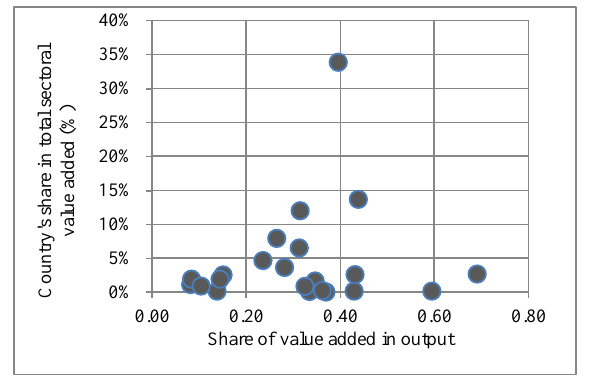
Fig. 2. Manufacture of computer, electronic and optical products in the EU in 2010.